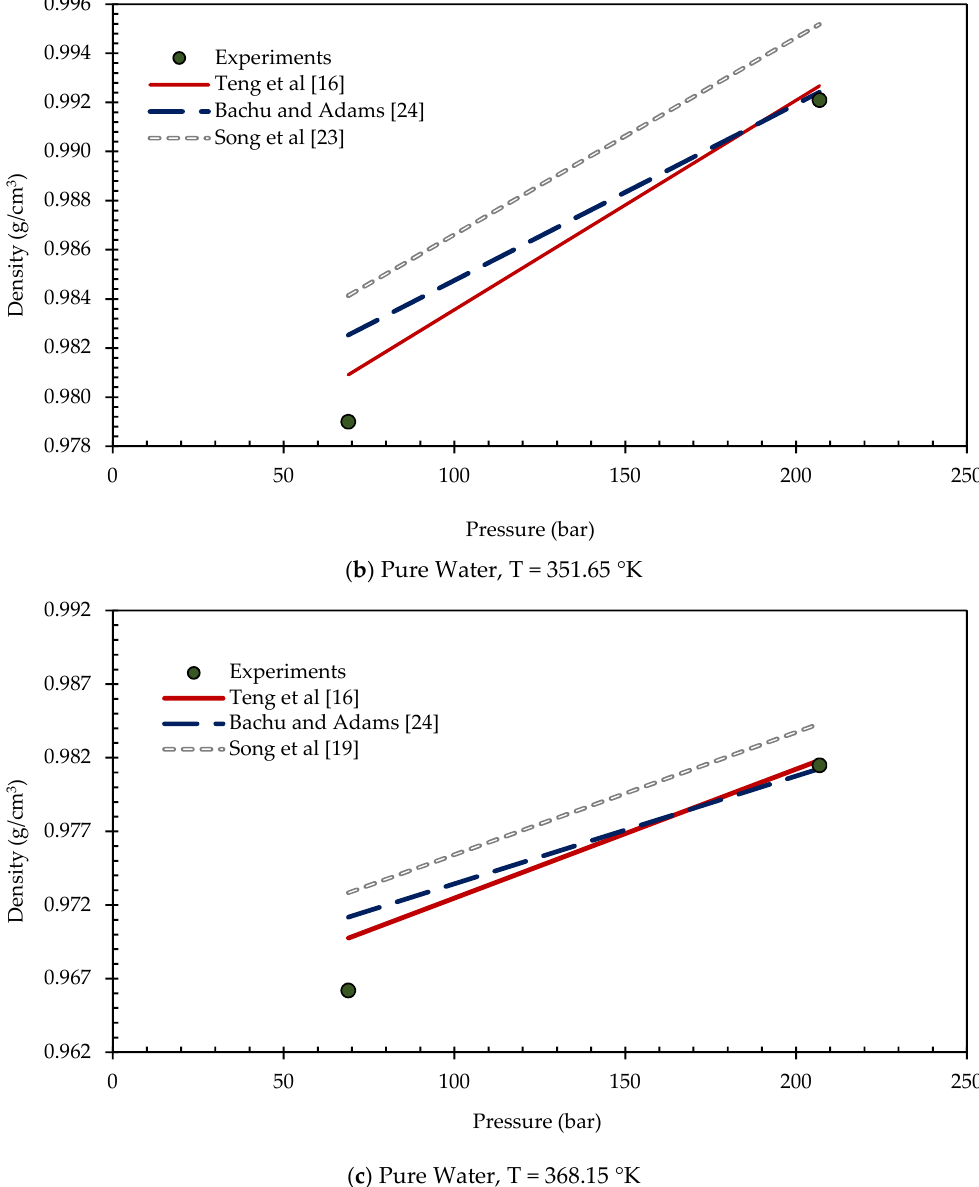
Figure 8. A comparison of experimental data from this study and three different model estimations for density of pure H 2 O saturated with CO 2 at ( a ) 328.15 °K, ( b ) 351.65 °K, and ( c ) 368.15 °K. The average and maximum absolute deviations of the predictions are listed in Table 4. As can be observed from Figure 8, as well as from the AAD and MAD values presented in Table 4, the correlation proposed by Teng et al. [16] with pure water density estimation from the model proposed by Islam and Carlson [28] results in the best estimation.